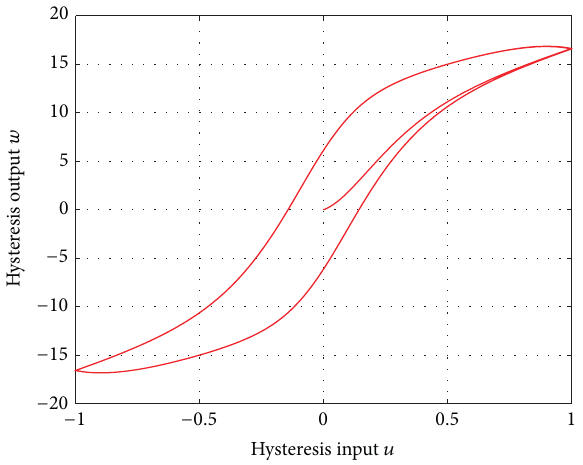
Figure 1: Hysteresis curves described by 𝜆(𝑢) = 10 tanh 5𝑢 + 8𝑢 .